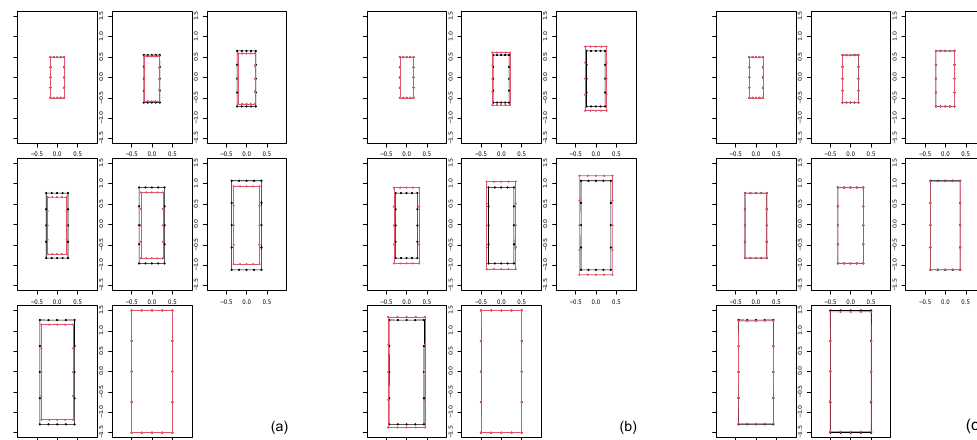
Figure 2. Affine spherical case results. ( a ) Left panel: geodesic trajectory shapes (black) plotted against the original parametric shapes (red). ( b ) Center panel: geodesic trajectory shapes (black) plotted against the shapes found via linear interpolation between the first and last shapes of the parametric dataset (red). ( c ) Right panel: geodesic trajectory shapes (black) plotted against autoparallel trajectory (red) built via shooting of the first two configurations of the geodesic.